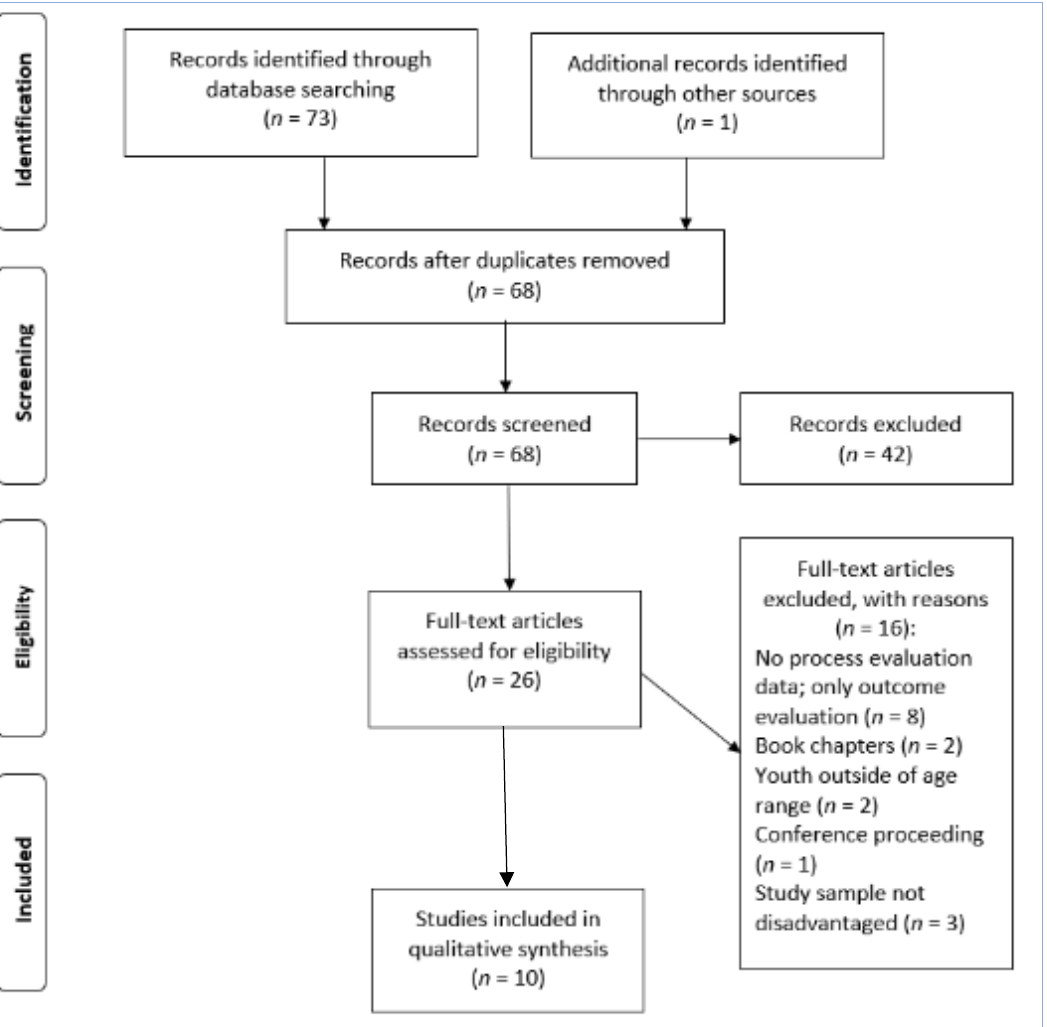
Figure 1. Process for Identifying, Screening, and Selecting Articles for Inclusion in This